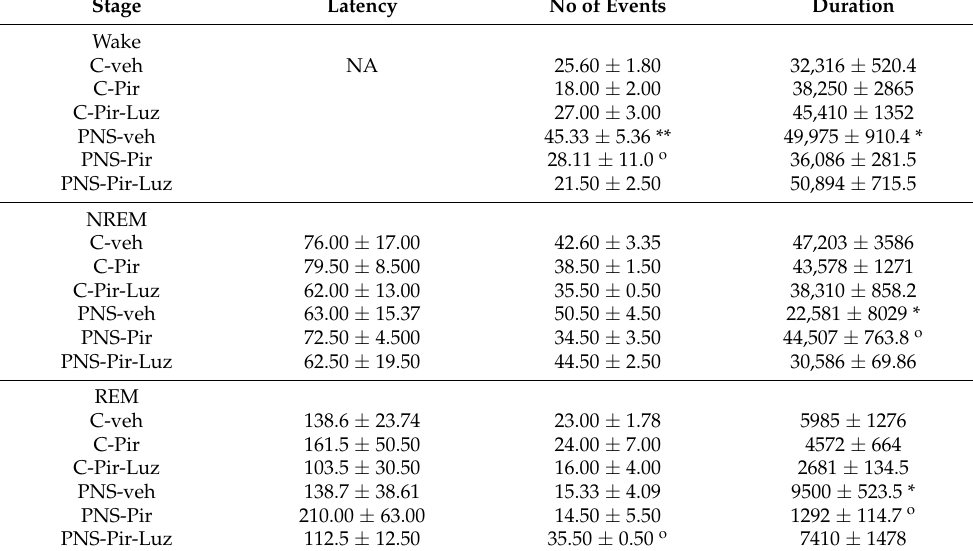
Table 1. Male rats: The latency to onset of non-REM (NREM) sleep and rapid eye movement (REM) sleep, number and duration of Wake events, NREM and REM in controls treated with vehicle (C-veh), controls treated with Piromelatine (Pir) (C-Pir), controls treated with Pir + luzindol (Luz) (C-Pir-Luz), rats exposed to prenatal stress (PNS) and treated with vehicle (PNS-veh), rats exposed to PNS and treated with Pir (PNS-Pir) and rats exposed to PNS and treated with Pir + Luz (PNS-Pir-Luz). Stage Latency No of Events Duration Wake C-veh NA